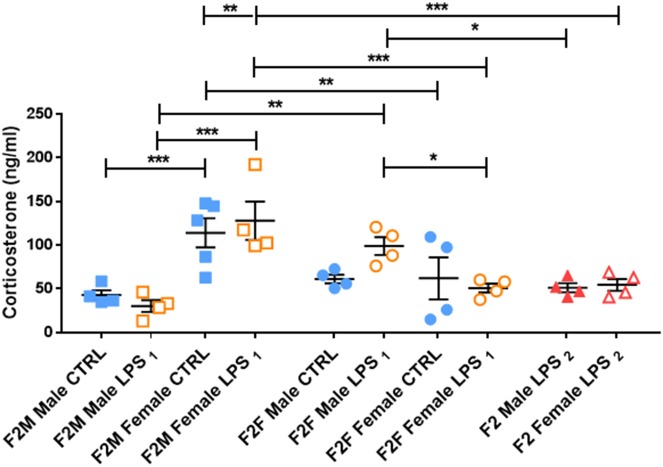
Basal plasma corticosterone concentrations in the Control, LPS1 and LPS2 groups in the F2 generation. All data are depicted as mean ± SEM (n = 4 per group). Significance is as follows: *p < 0.05; **p < 0.01, ***p < 0.001.